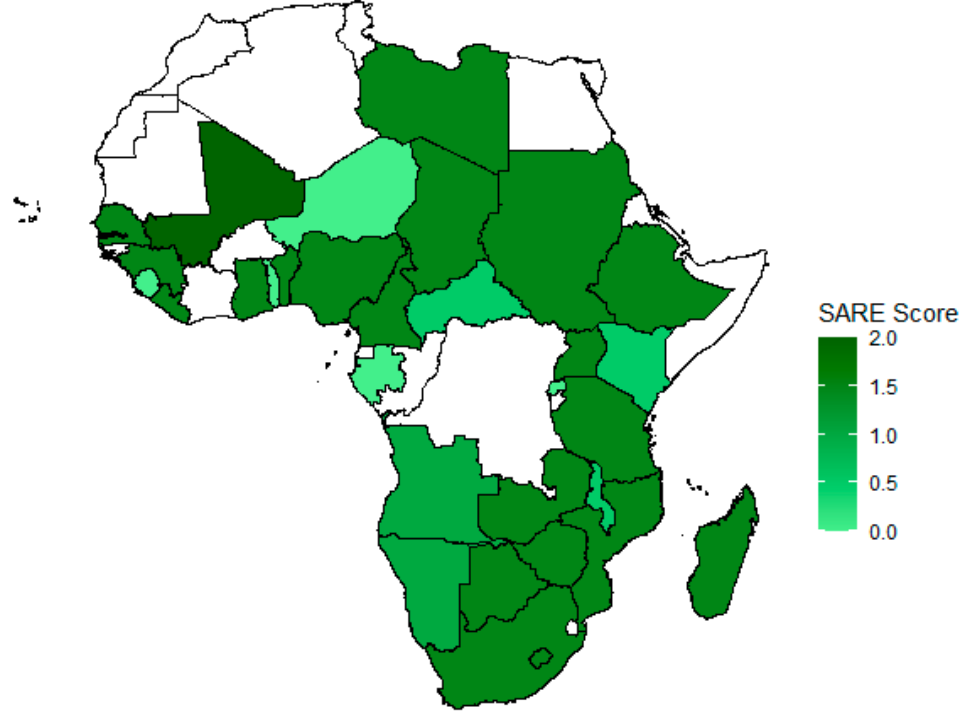
Figure 2. Distribution of SARE scoring levels across Africa as of 2019. Note: Countries where no data was available are marked white.